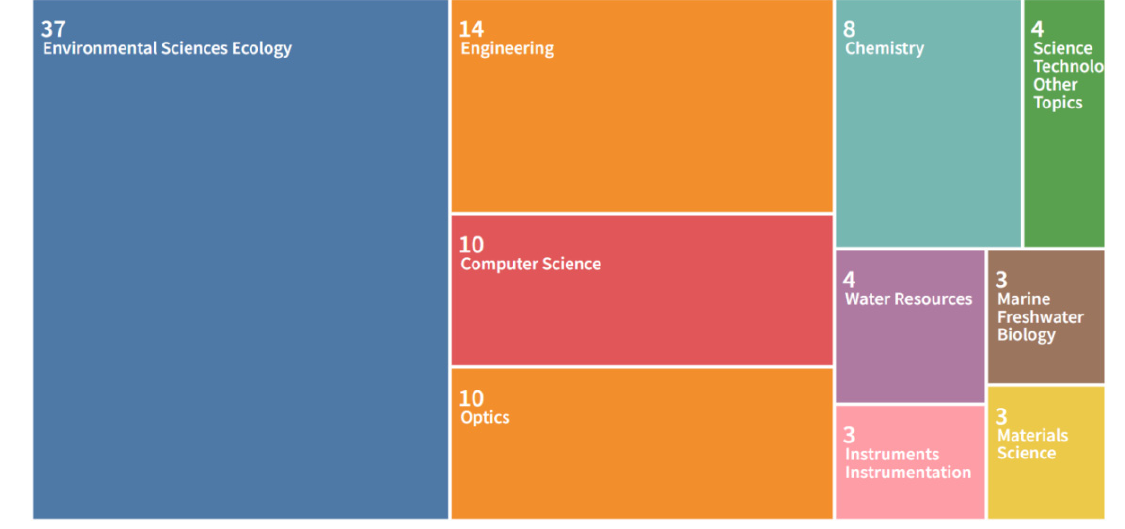
Figure 4. Top 10 hot research areas (generated using Web of Science on data).